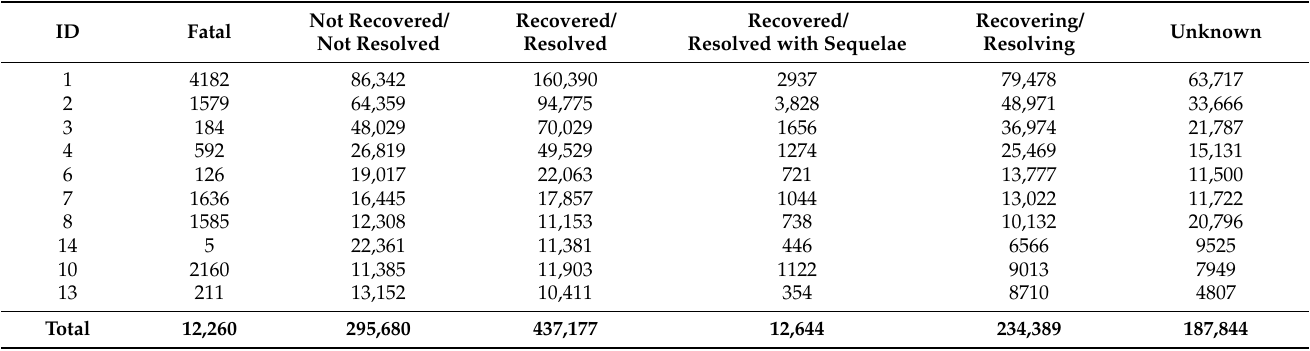
Table 2. Outcome of reports of suspected major adverse events related to Comirnaty vaccine after 459 million doses administered